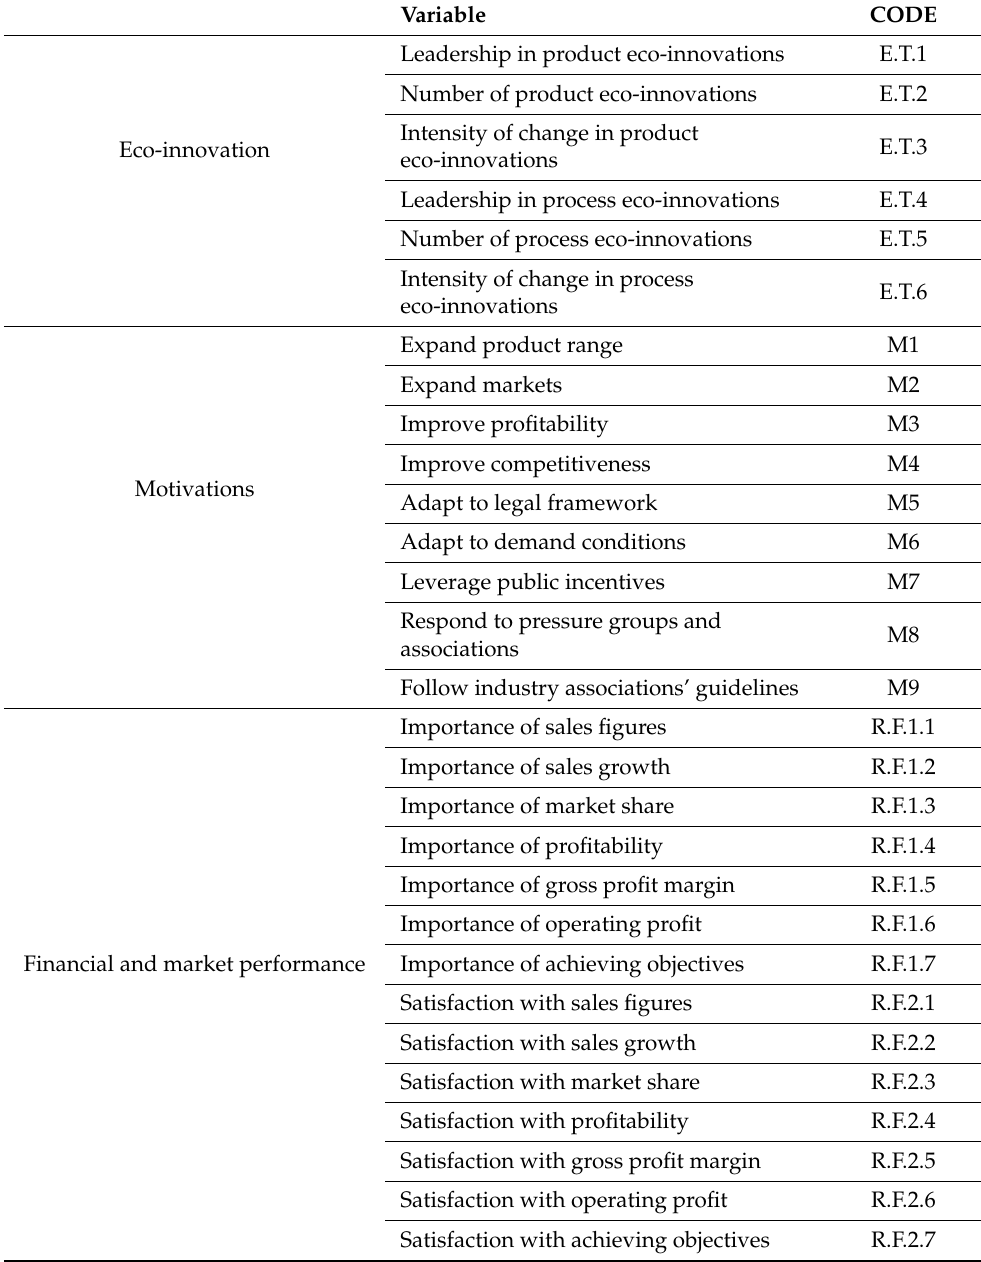
Table A2. Variables and codes.